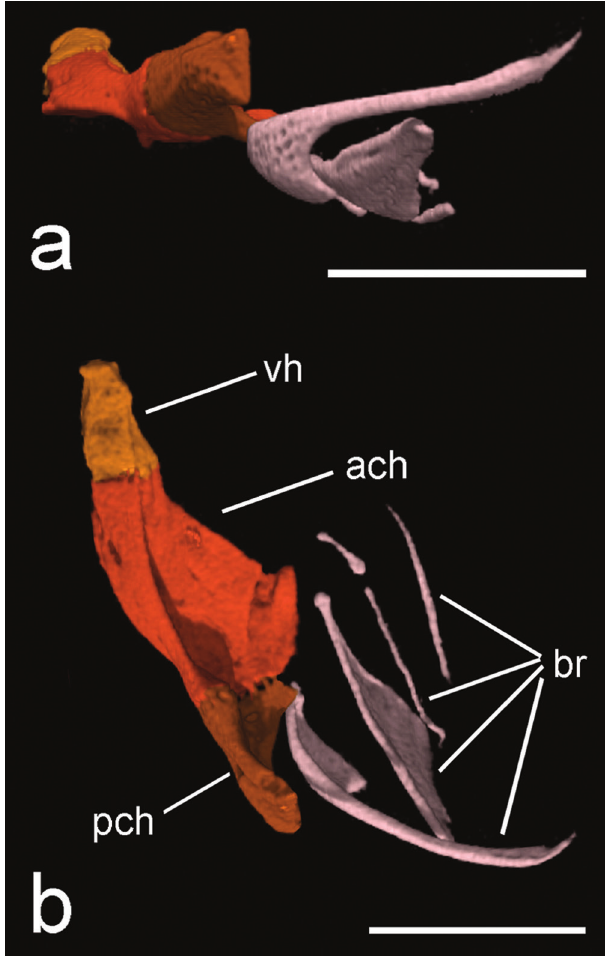
Fig. 6. HRXCT model of hyoid arch of Hoplomyzon cardosoi , MCNG 375, holotype, 18.5 mm SL. a. Left side in lateral view. b. dorsal view (anterior towards left). ach: anterior ceratohyal; br: branquiostegal rays; vh: ventral hypohyal. Scale bars = 1 mm.